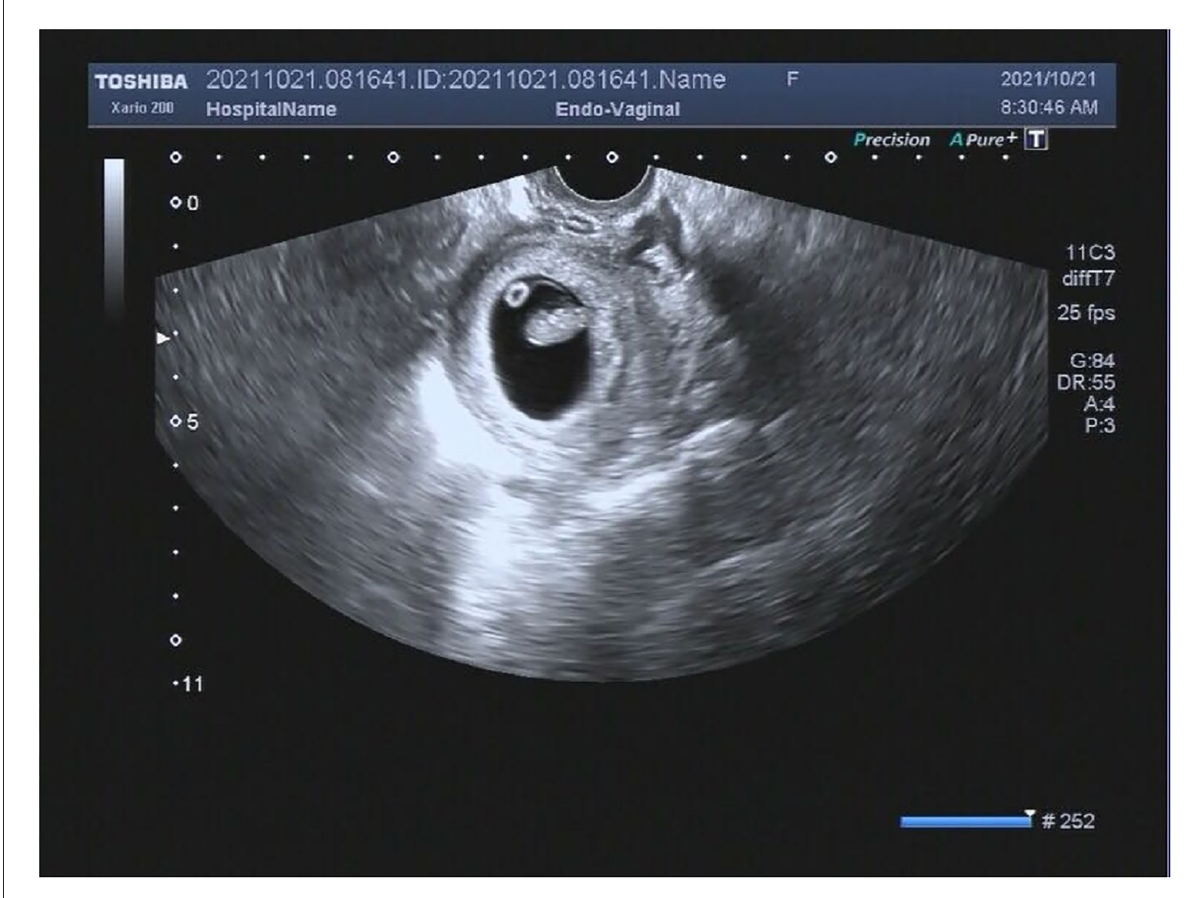
FIGURE1 Transvaginal sonography of 8 weeks of gestation of